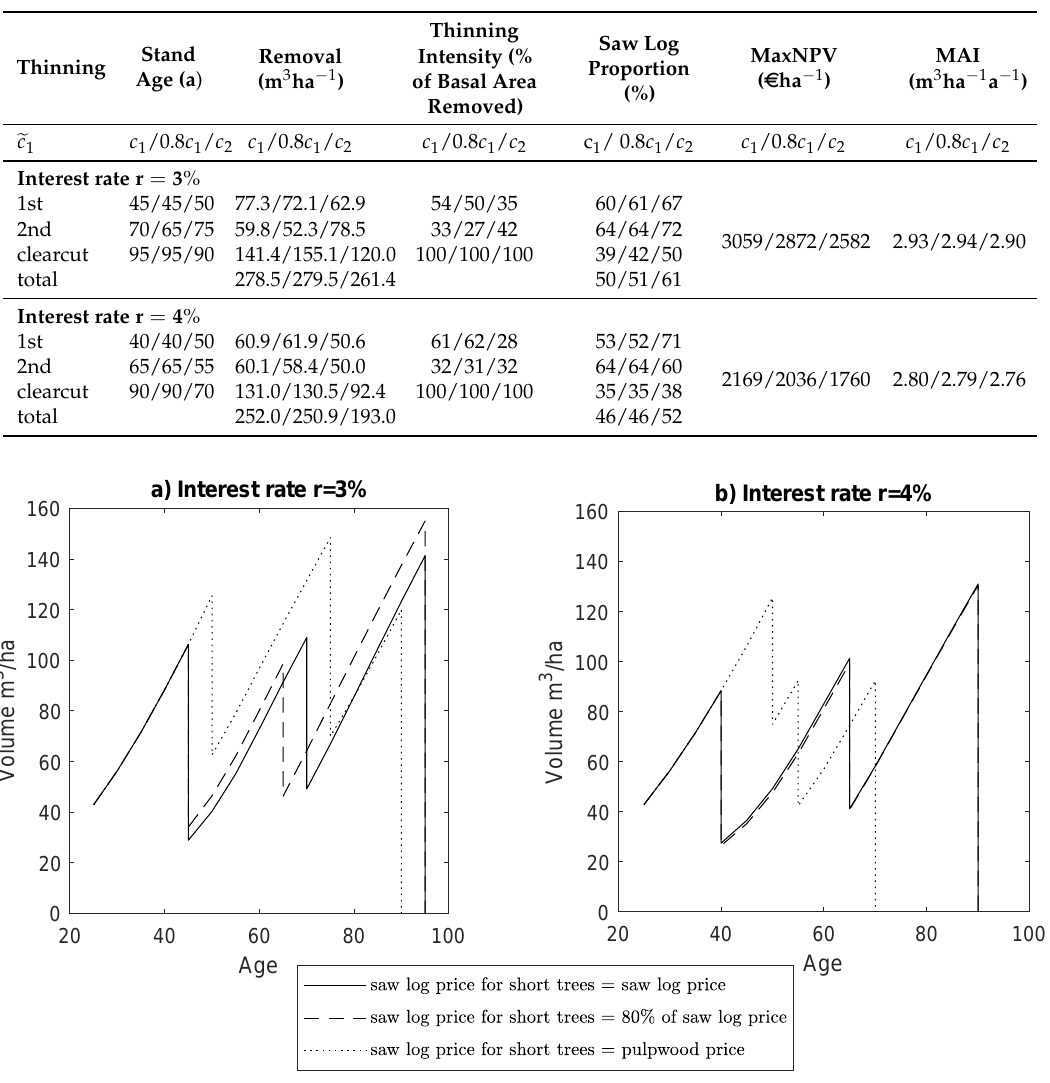
Table 1. Optimal stand-level managements when initial stand density is 1000 stems ha − 1 (seeded trees).